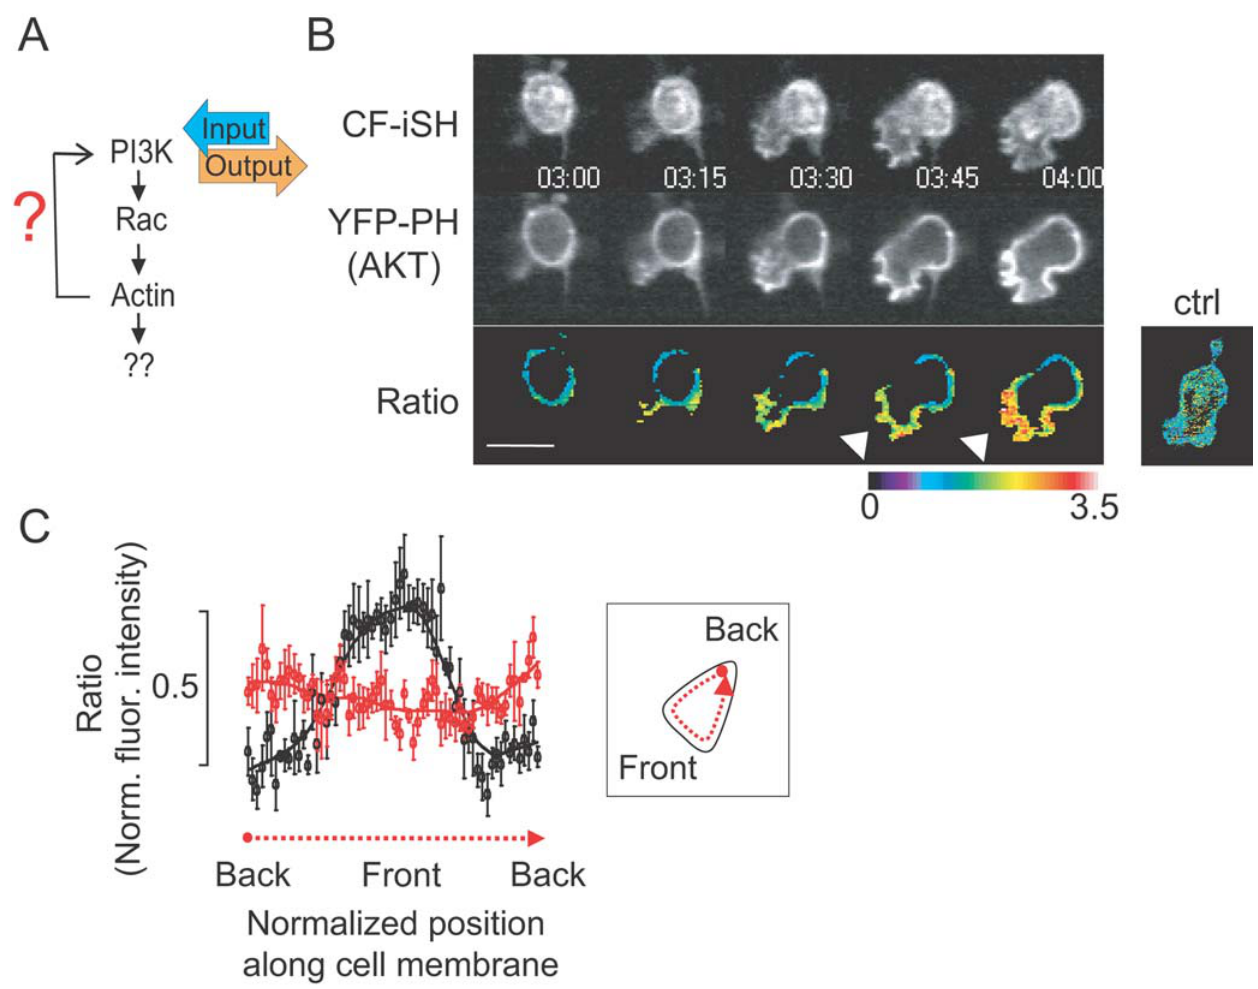
Figure 5. Delayed triggering of PIP 3 polarization after an initial non-uniform increase in PIP 3 . (A) Schematic representation of experiments conducted in (B) and (C). (B) Time series analysis of PIP 3 accumulation at the front of a migrating cell following uniform activation of PI3K in an unpolarized cell. Shown cell expresses the PI3K activator (CF-iSH, top row) and the PIP 3 biosensor (YFP-PH(AKT), middle row). Bottom images were produced by ratioing the YFP-PH(AKT) images over the CF-iSH image. Note the higher ratio value at the pseudopod of the emerging polarized cells (arrowheads). The control panel on the right shows a ratio image of a cell expressing CF-iSH over a generic plasma membrane marker (myristoylated- and palmitoylated-YFP), arguing that CF-iSH is itself suitable as a uniform PM marker. Time unit; minute and second. (C) Line-scan analysis of the ratio images shown in (B) and of a control cell where a PM-YFP was again used instead of the YFP-PH(AKT). Normalized ratio values within a peri-plasma membrane region were calculated for the PI3K activated cells (analysis scheme is shown in inset). Black lines represent the normalized YFP-PH(AKT) distribution and red lines the control experiments showing that the normalization technique takes into account differences in membrane concentration. Error bars are given in S.E.M. (n=5). Scale bars, 10 m m.